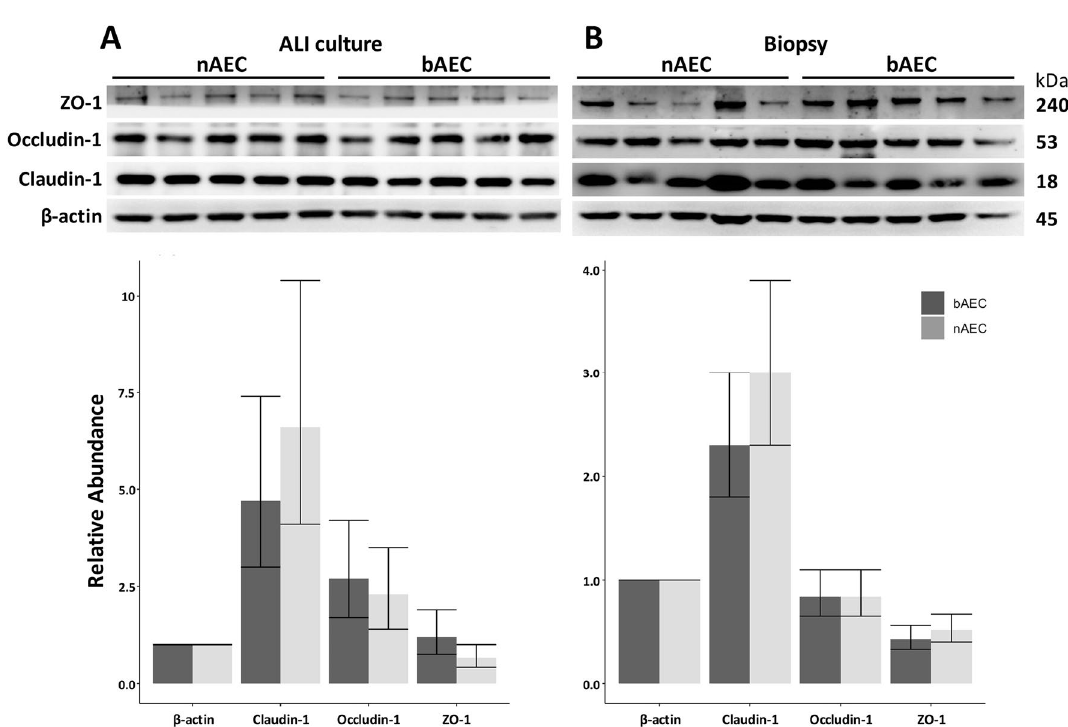
Figure 3. Tight junction proteins are similarly expressed in nAEC and bAEC cells for ALI and biopsy epithelia. ( A ) Ex vivo cultures of differentiated nAEC and bAEC express similar proportions of the TJ proteins Zonula occludens-1 (ZO-1), Occludin-1 and Claudin-1. ( B ) A portion of the biopsy sample used to generate the ex vivo models also produced no significant difference for the TJ factors. Blots were sectioned to probe the area corresponding to the molecular weight of the target protein. With the exception of β-actin for the ALI culture Western blot in ( A ), outcomes were derived from a single transfer membrane for the respective experiments (i.e. ALI vs biopsy) to minimise inconsistencies produced by inter-blot variation. Original blots are in Supplementary Fig. S2 online. Uncertainty intervals are 95% CI; n = 5 per culture group. Values were normalised to the β-actin loading